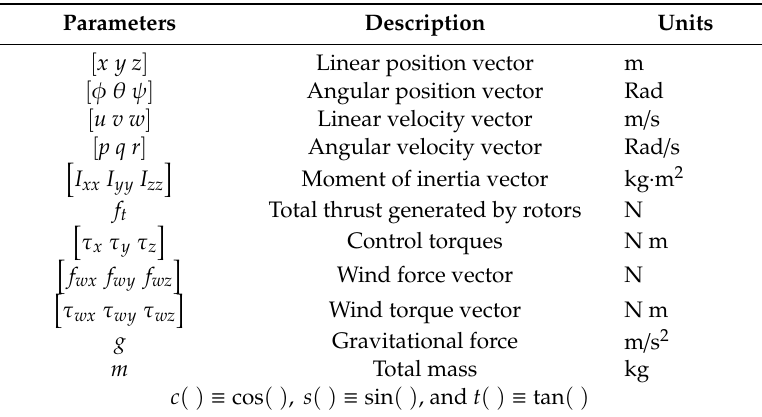
Table 1. Parameter